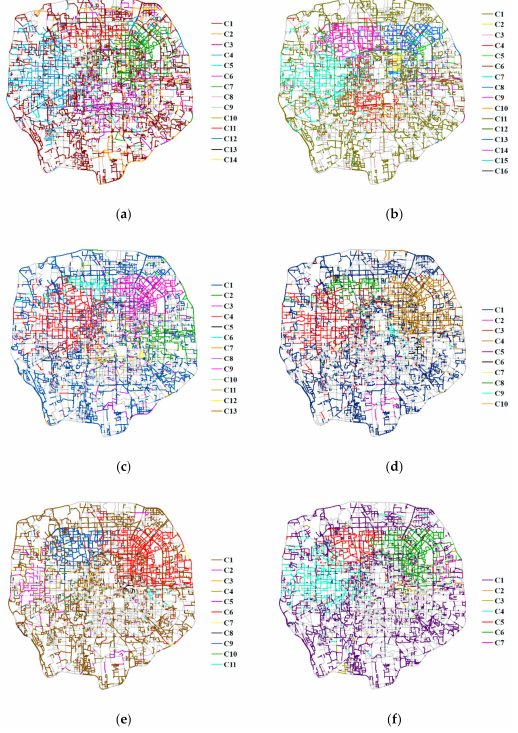
Figure 12. Communities discovered by DYNMOGA: ( a ) 8:00–9:00; ( b ) 9:00–10:00; ( c ) 10:00–11:00;